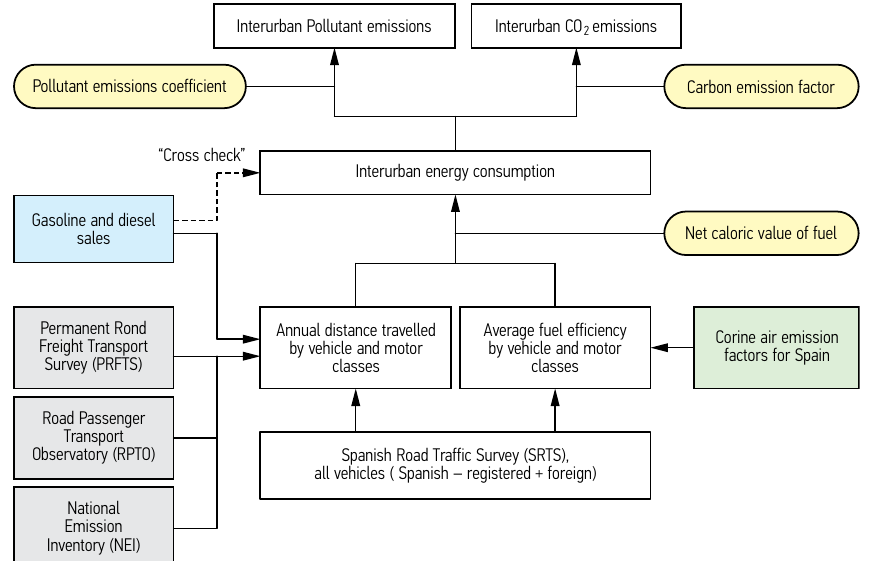
Fig. 3. Approach used for the calculation of interurban estimates of CO 2 and pollutant emissions from road